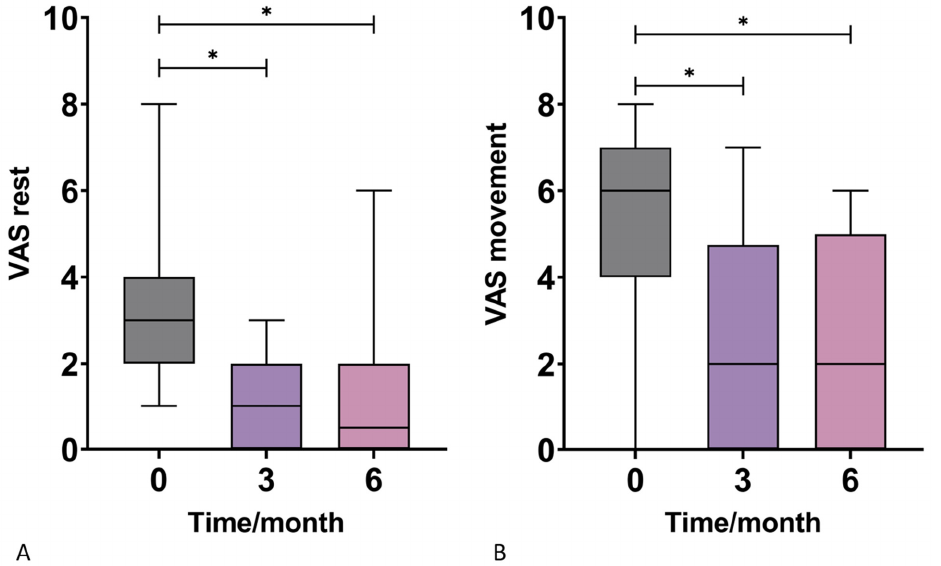
Figure 1. Box-plots show the distribution of visual analog scale (VAS) scores for pain in rest ( A ) and movement ( B ) at baseline and at 3 and 6 months after the application of autologous conditioned adipose tissue and leukocyte-poor platelet-rich plasma. Statistically significant VAS improvement in response to therapy was observed at 3 and 6 months at both rest and during movement. *— p < 0.05 (Wilcoxon test).